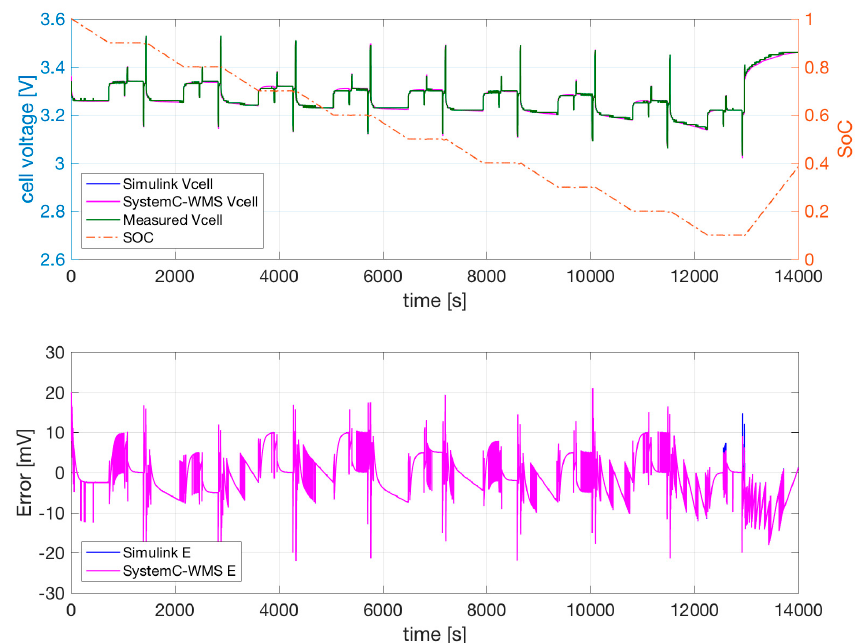
Figure 9. Measured voltage, SoC, SystemC-WMS, and Simulink simulations of the model of Figure 1b with parameters obtained with the extraction procedure and optimization. T = 40 °C. The lower part of this figure shows the error between SystemC-WMS and measurements and between Simulink and measurements.